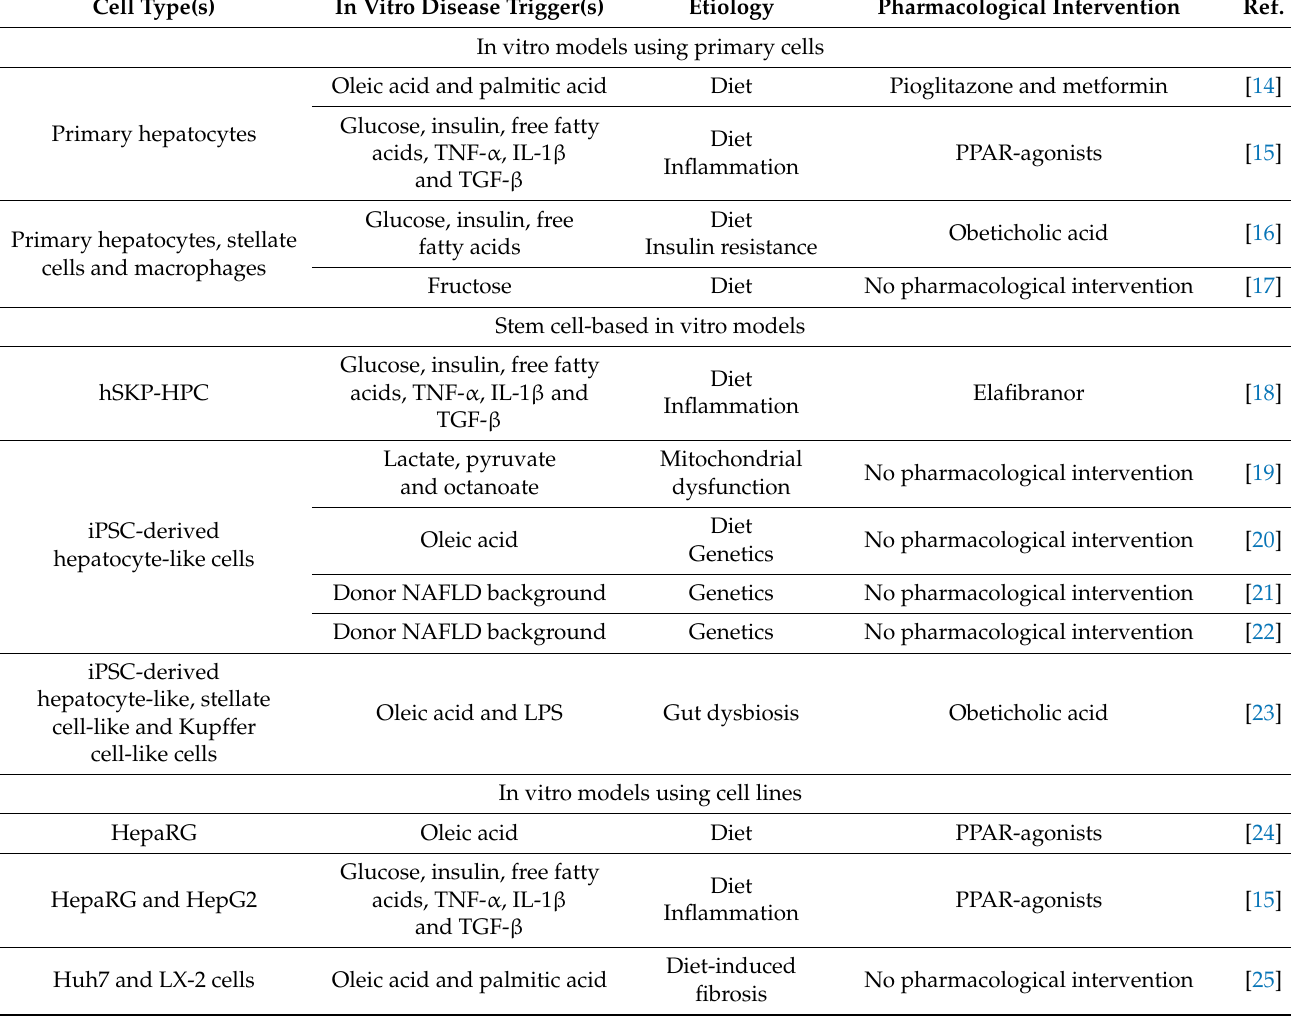
Table 1. Human-based in vitro models of NAFLD. [Abbreviations: hSKP-HPC: human